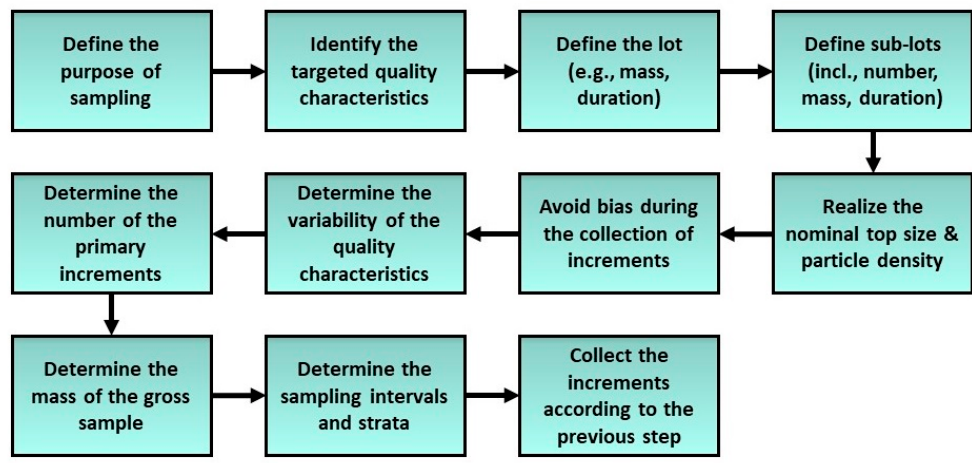
Figure 4. Operational sequence of eleven steps for an unbiased sampling scheme according to ISO 11648–part 2 [69] (own illustration).